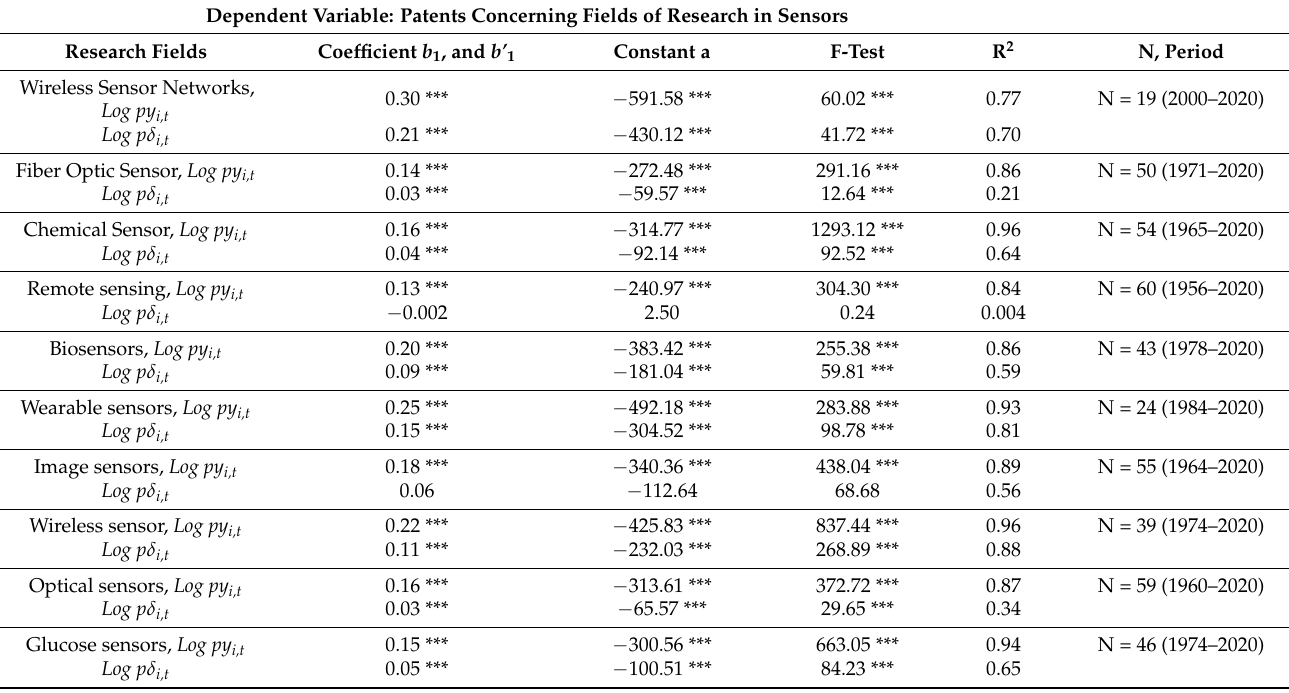
Table 2. Estimated relationships of patents in research fields of sensors as a function of